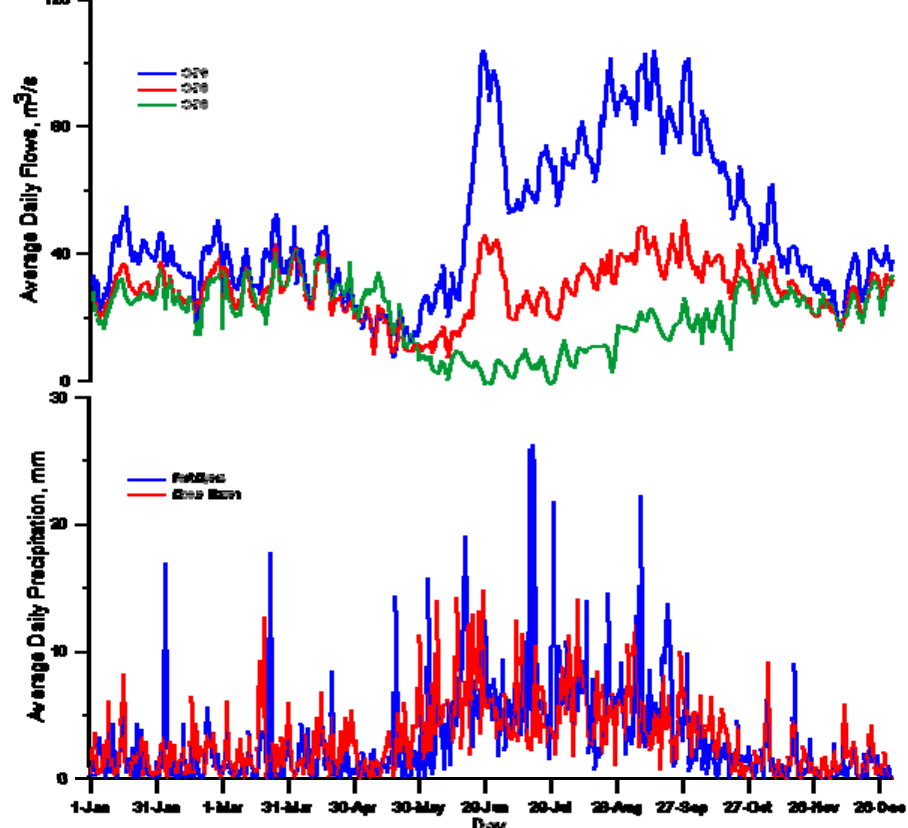
Figure 10. Average daily flows and precipitation (secondary Y-axis) at the Caloosahatchee stations during the period of